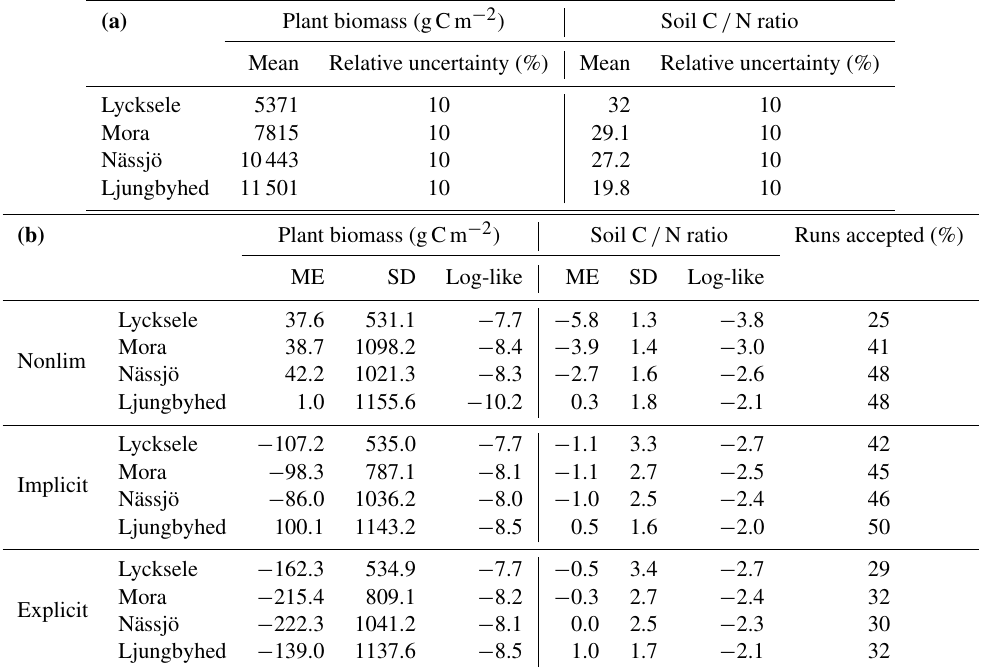
Table 4. Prior values of variables used for model calibration and accepted relative uncertainty (a) , and posterior model performance indica- tors (b) : mean error (ME) between simulated and measured values, standard variation in ME (SD), and summed log likelihood of all accepted runs for simulated standing plant biomass (gCm − 2 ) and soil C / N ratio after the 100-year simulation period. (a) Plant biomass (gCm − 2 ) Soil C / N ratio Mean